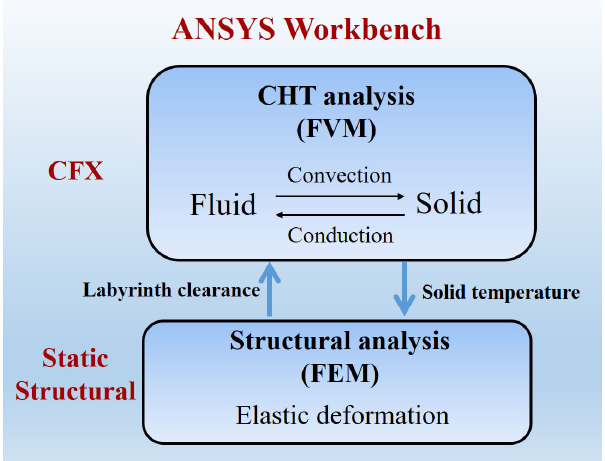
Figure 4. Two ‐ way aero ‐ thermo ‐ elasto coupling solver. The solution process is shown in Figure 5. Solid temperature and labyrinth clearance were transferred between the two modules, and the solution was iteratively solved until the solution converged in terms of seal clearance. The seal clearance convergence criterion